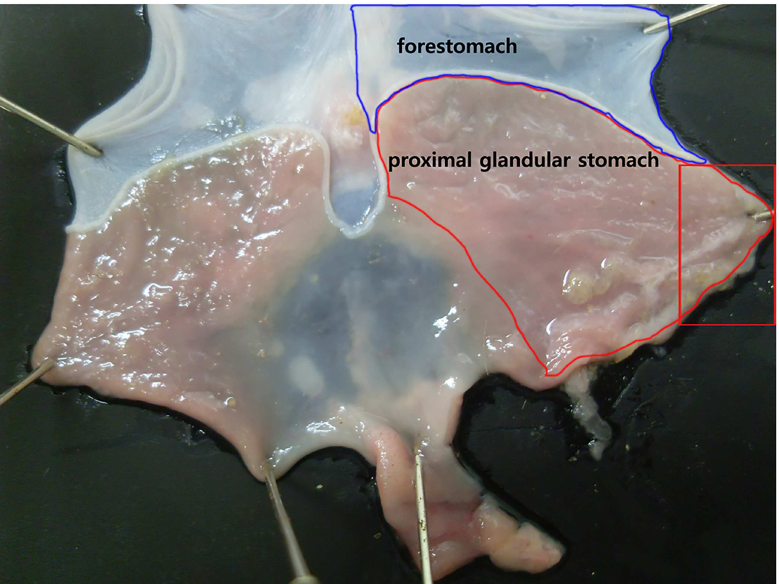
Fig 1. Diagram of rat stomach. The stomach of the rat is dividedinto the forestomach (pars proventricularis) and glandularstomach (pars glandularis). For this experiment, the proximal glandular stomach of F344 rat was used after removingforestomach. Stomach was openedalongthe greater curvature and about a one- centimeter length of proximal glandularstomach (corpus) was used for immunohistochemistry (rectangular box in the right